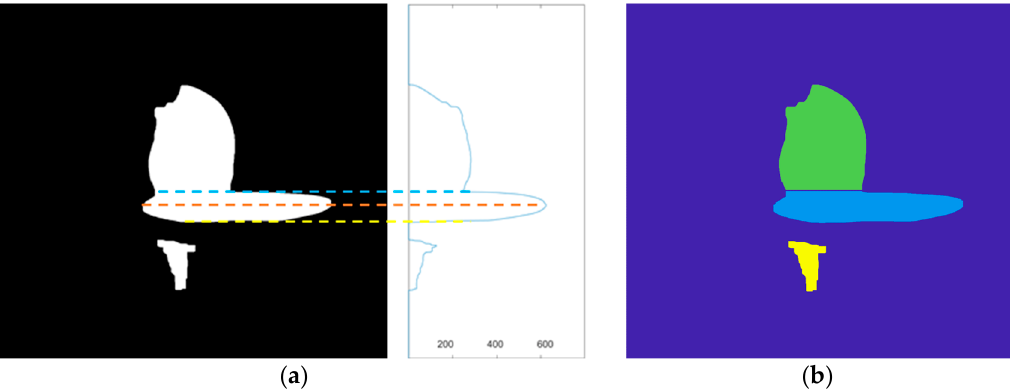
Figure 5. ( a ) Accumulation along the image row, where the orange dotted lines indicate the height of the maximum length of the molten pool, the blue dotted lines indicate the height of the boundary between the molten pool and droplet, the yellow dotted lines indicate the height of the boundary between the molten pool and reflection. The horizontal axis represents Yi (the cumulative grey value in row i of the image). ( b ) Image segmentation result.